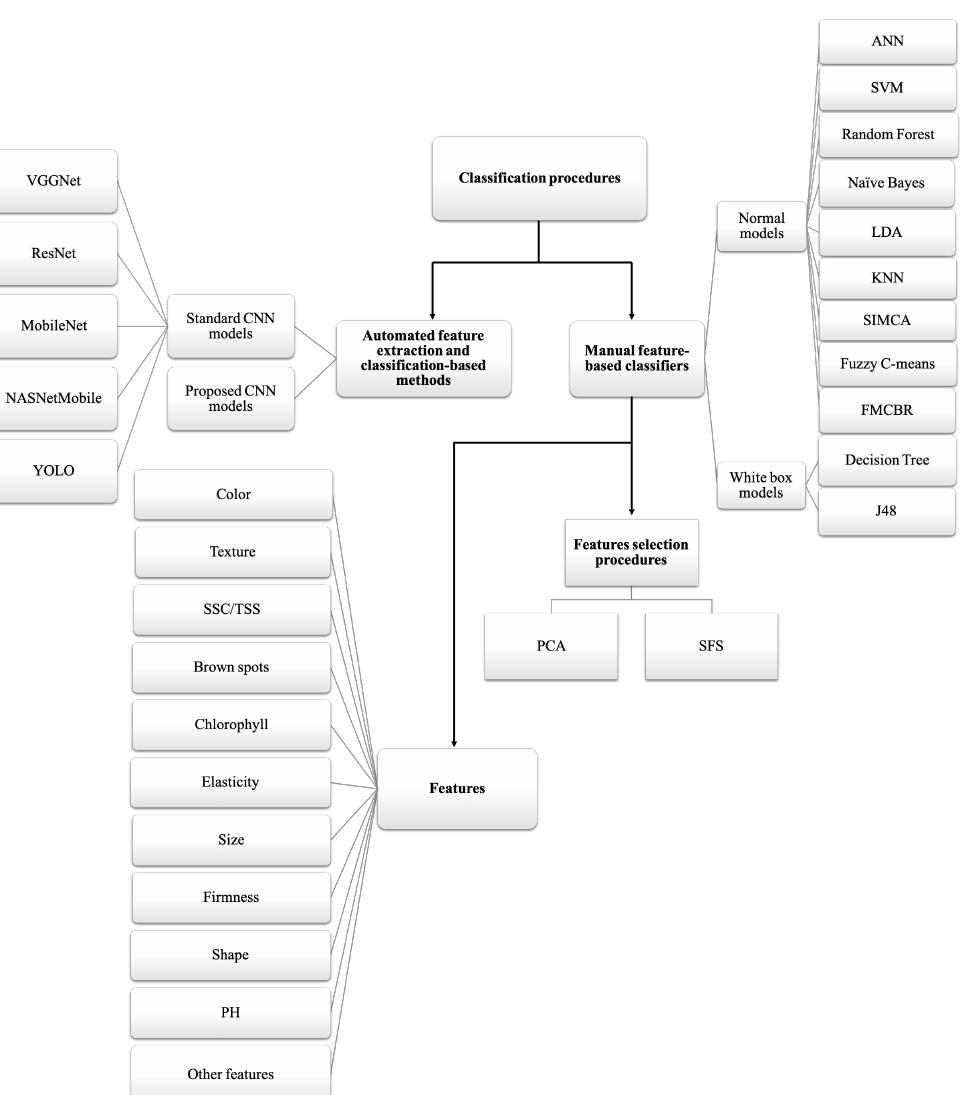
Figure 4. Classification and feature-based